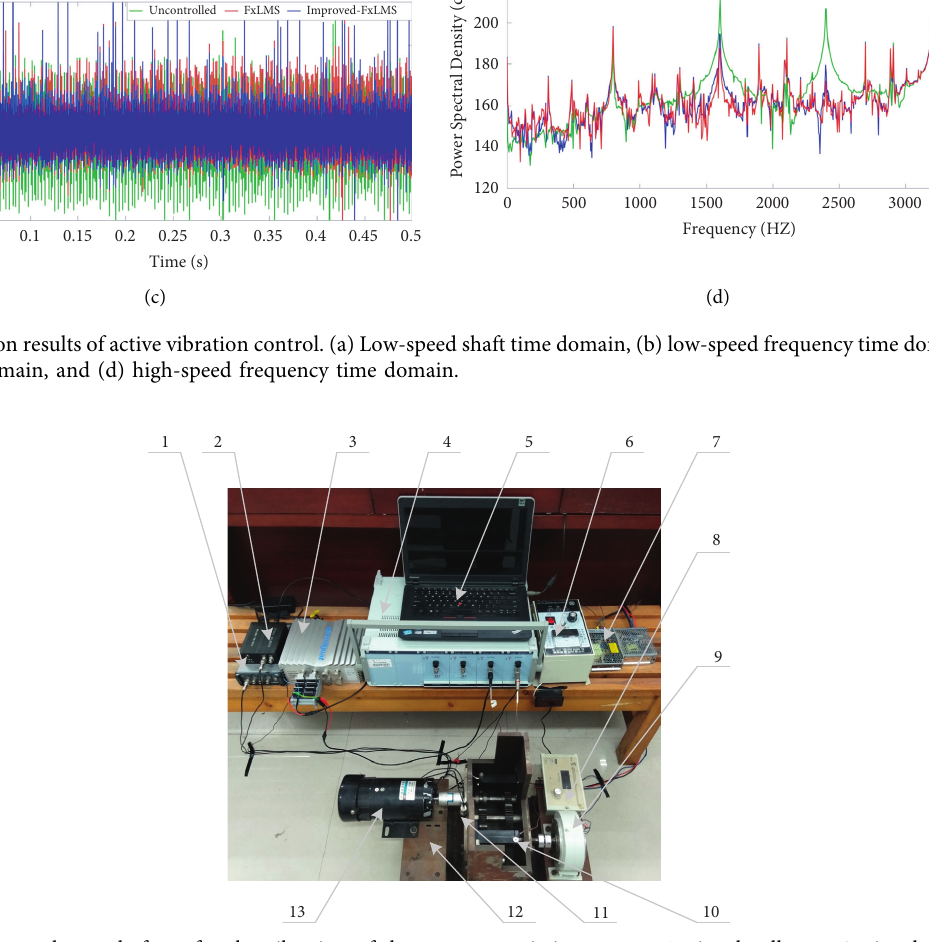
Figure 13: Active control test platform for the vibration of the gear transmission system. 1: signal collector, 2: signal conditioner, 3: controller, 4: power amplifier, 5: PC, 6: motor, 7: power, 8: torque adjuster, 9: magnetic powder, 10: piezoelectric actuator, 11: acceleration sensor, 12: multistage gear transmission system, and 13: adjustable speed